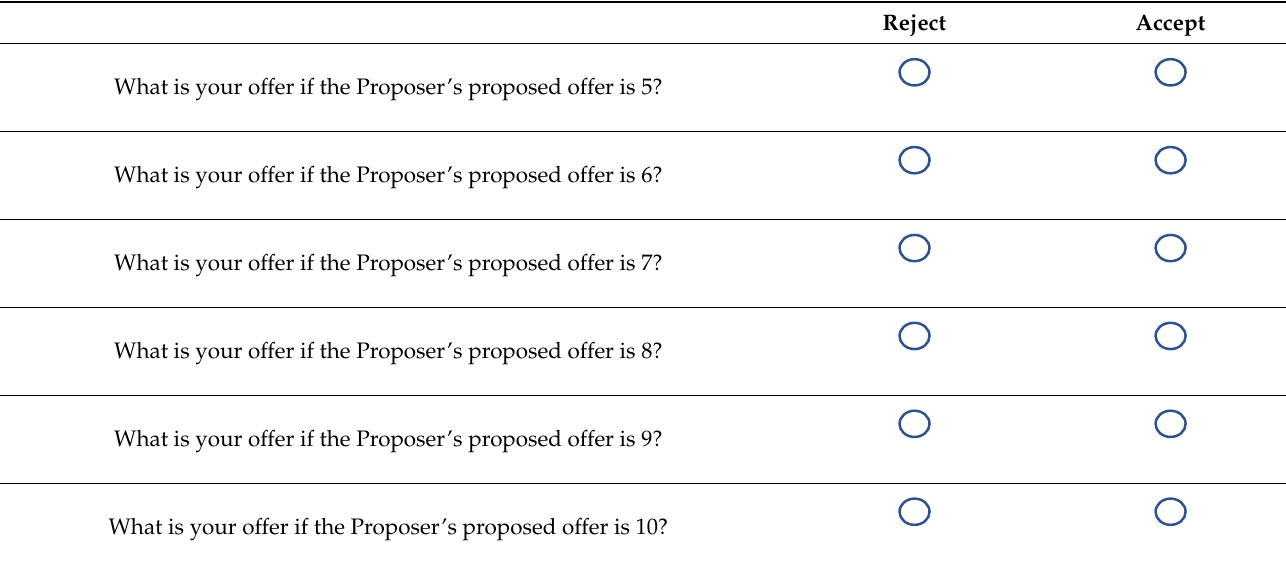
Table A1 . Accounting for the agent’s own proposal when he is in proposer’s role, in addition to the partnered proposer’s proposal. Estimates for linear regression of agent’s response function for non ‐ binding setting proposal (where there are no limits), Upper Bound, and Lower Bound, and pooled settings. Right and left censoring was conducted via Tobit in Upper Bound and Lower Bound set ‐ tings and in the pooled setting. Robust standard errors (N = 40) are reported in all cases.